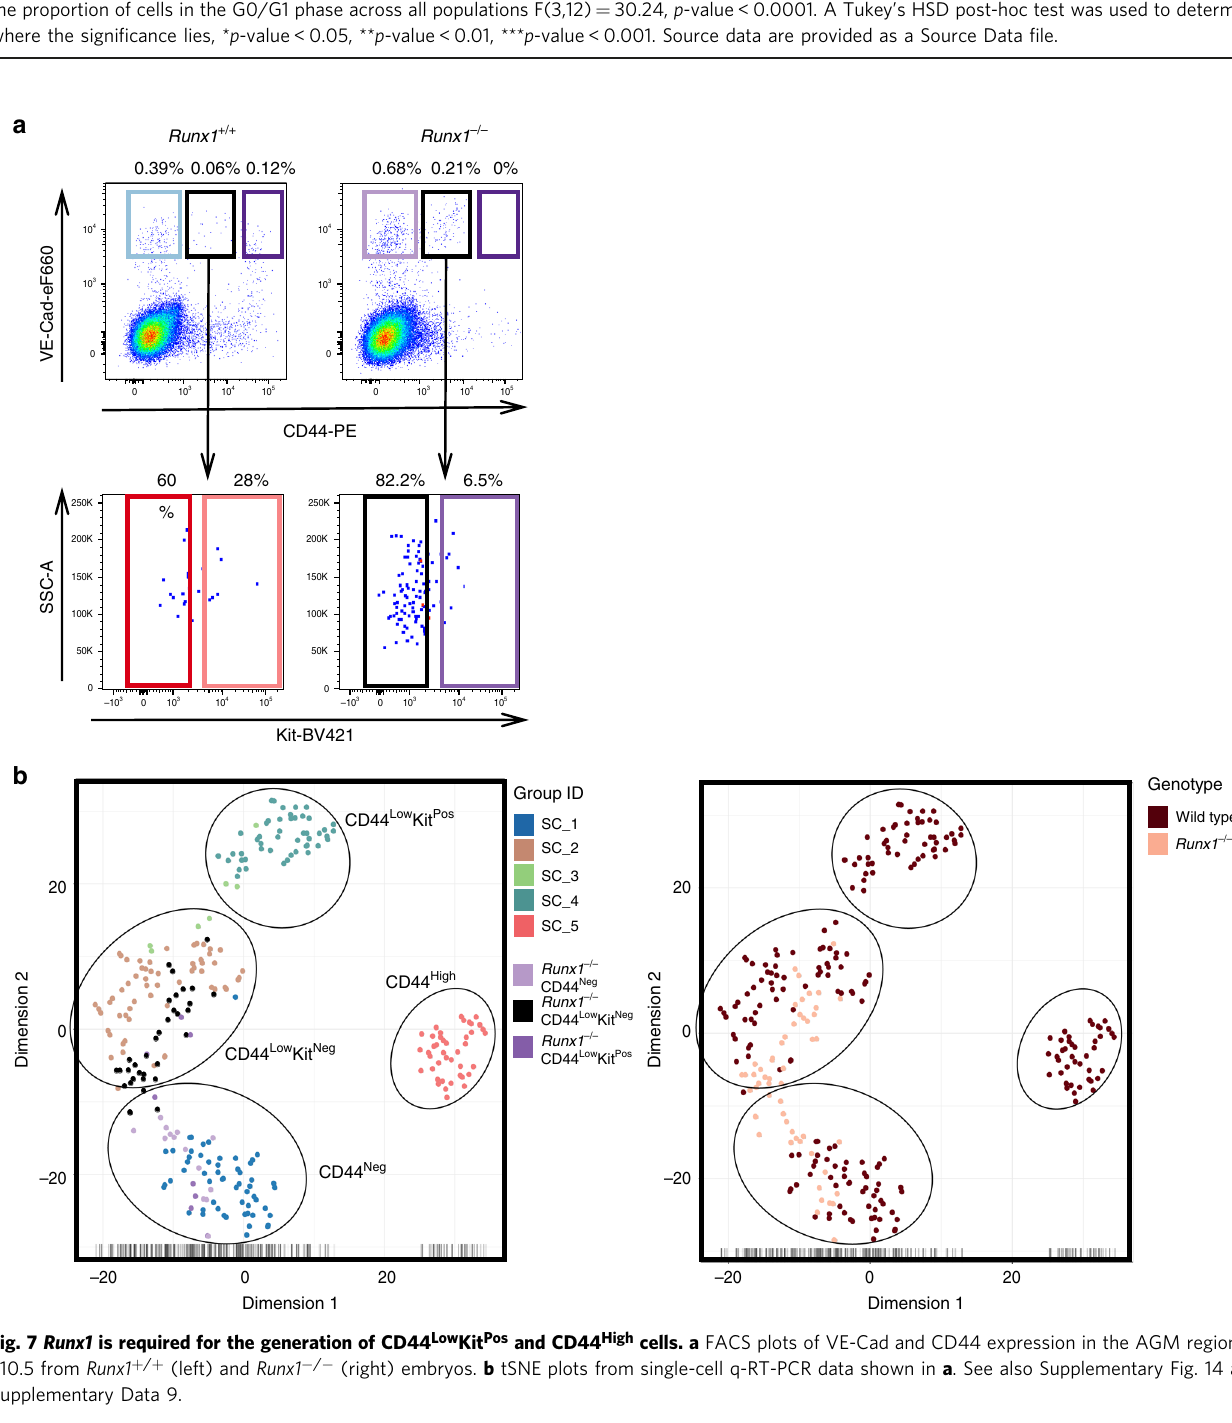
from Runx1 + / + vs. Runx1 − / − embryos, indicating that RUNX1 is not necessary for the formation of these endothelial cells but for the promotion of the transition into CD44 Low Kit Pos cells (Supplementary Fig. 14).